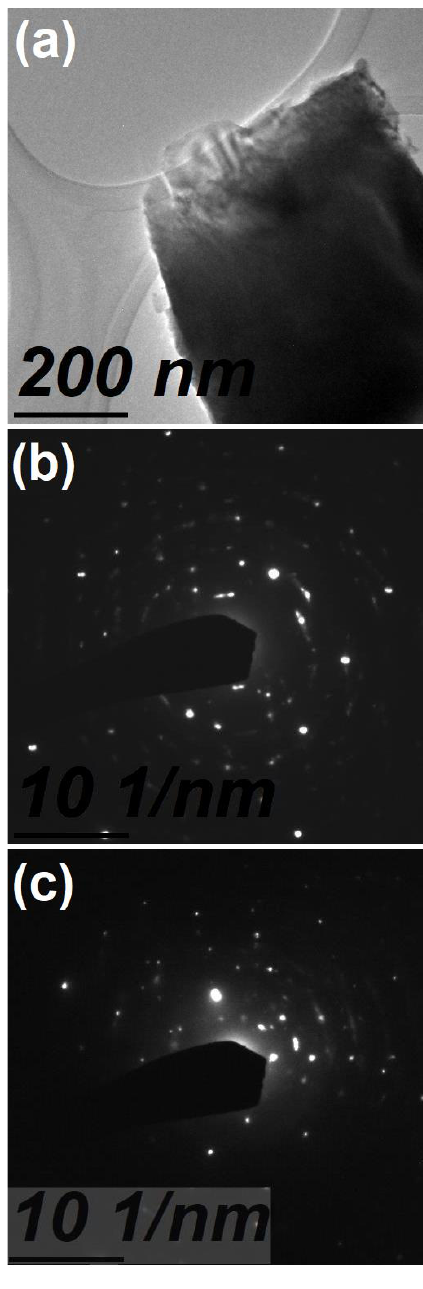
Figure 5. ( a ) TEM micrograph of the sample of Mg-Zn co-doped GaN powders, ( b ) electron diffraction pattern of the undoped GaN powders, and ( c ) electron diffraction pattern of the Mg-Zn co-doped GaN powders.